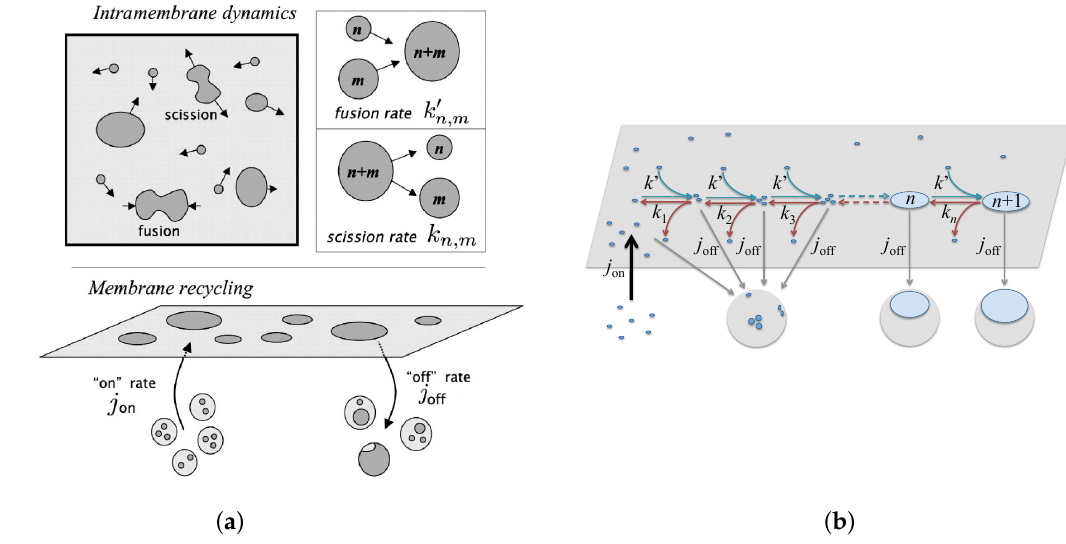
FIG. 1. The model: (a) All domains can undergo scission and fusion; (b) domains are deposited and removed from the mem- brane stochastically. Figure 8. Examples of recycling schemes. ( a ) In the membrane, domains can undergo scission or fusion, whatever their size. Reproduced from [57], with permission from the American Physical Society, discussed in further detail below; ! 0 when there is no Copyright 2005. ( b ) In this alternative scheme, clusters can only gain or lose proteins by exchange of ! monomers with the surrounding membrane (Ostwald ripening) because scission and fusion events are assumed to be rare. Reproduced from [199], with permission from the American Chemical Society, Copyright 2016. In both examples, monomers are injected into the membrane from the cytosol at a rate j on , either by exocytosis in ( a ) or by a monomer flux from the cytosol in ( b ). Multimers are internalized through endocytosis with a rate j off that is independent of their